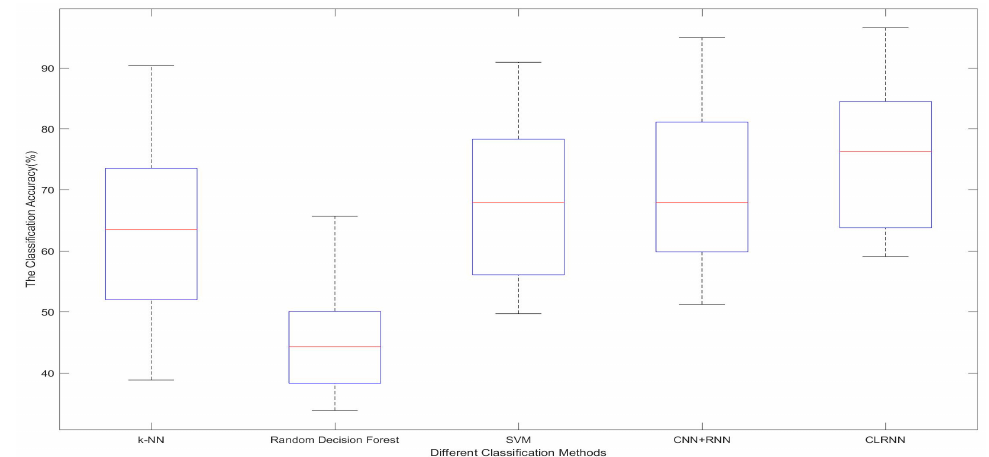
Figure 8. Emotion recognition accuracies with different classification methods.